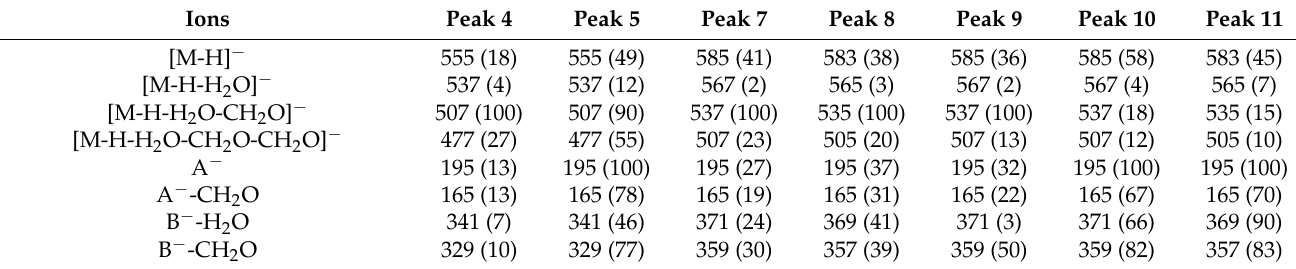
Table 3. MS/MS fragmentation patterns of trilignols of the methanol 90% fraction of the total extract of C. cowellii . Ions Peak